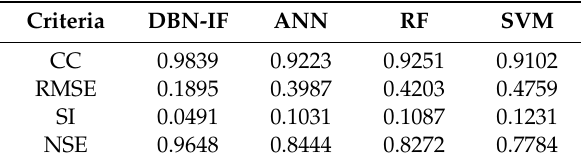
Table 9. The CC, RMSE, SI, NSE of WVHT predictions with lead time = 3 h.